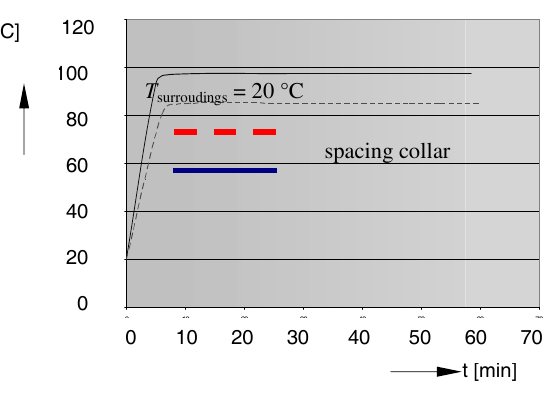
Fig 2 . Heating characteristic of the junction at the transmitter power of 60 % (slack and polluted junction) There is the temperature dependence in Fig 3 of the junction (feeder line – spacing collar, capacitor frame) and feeder line on the transmitter power in case of the junction being in order (drawn up and clear).